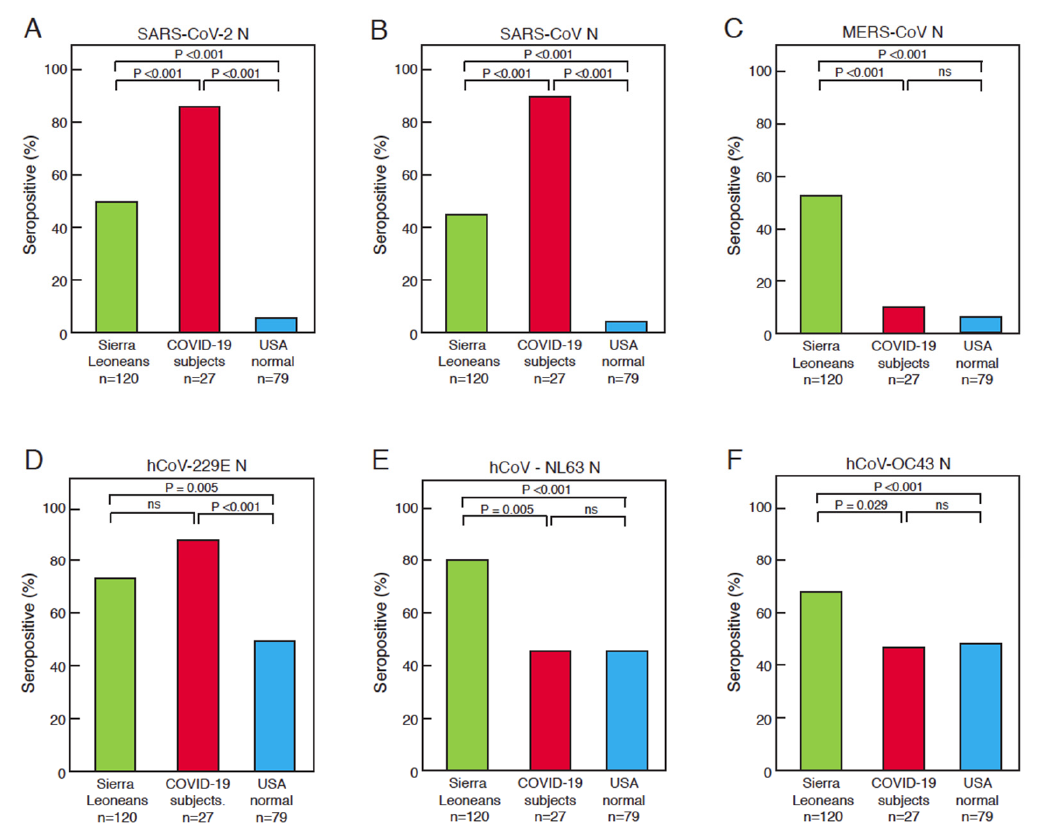
Figure 2. Serological responses to coronavirus antigens by Sierra Leoneans, COVID-19 subjects, and United States normal blood donors. The percentage of positive results for the indicated coronavirus proteins for the three cohorts are shown: ( A ) SARS-CoV-2 N, ( B ) SARS-CoV-2 RBD, ( C ) MERS-CoV-N, ( D ) hCoV-229E N, ( E ) hCoV-NL63 N, and ( F ) hCoV-OC43 N.